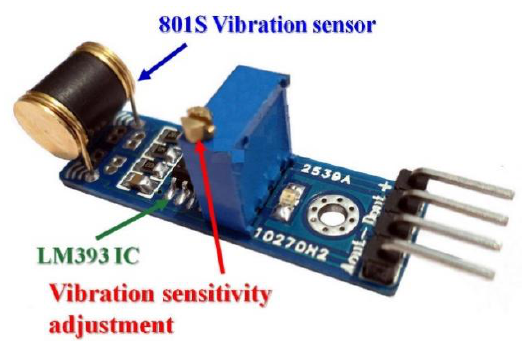
Figure 18. Digital and analog vibration sensor.